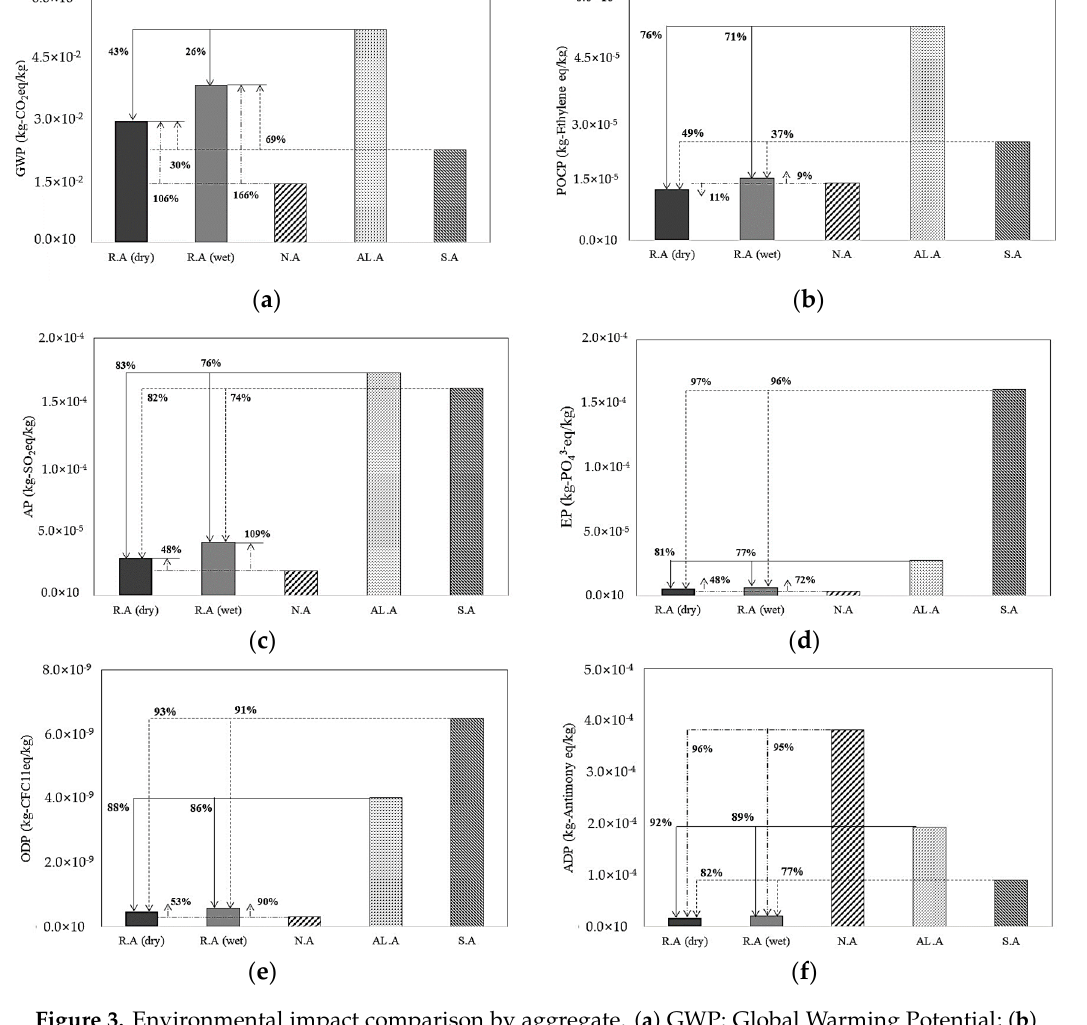
Figure 3. Environmental impact comparison by aggregate. ( a ) GWP: Global Warming Potential; ( b ) POCP: Photochemical Ozone Creation Potential; ( c ) AP: Acidification Potential; ( d ) EP: Eutrophication Potential; ( e ) ODP: Ozone Depletion Potential; ( f ) ADP: Abiotic Depletion Potential